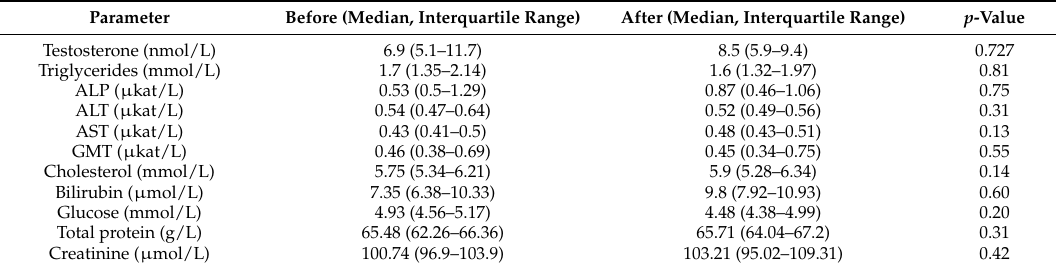
Table 2. Serum markers of tested cohorts; results of the Wilcoxon matched pairs test.